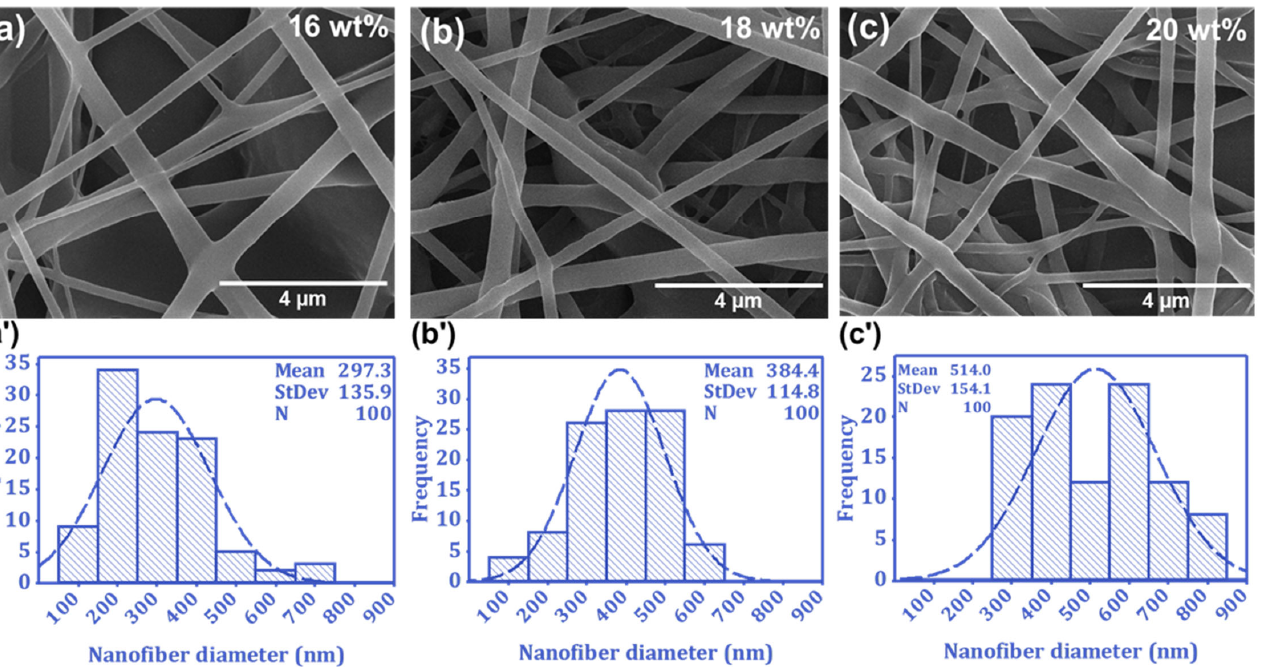
Figure 3. ( a – c ) SEM images and ( a ′ – c ′ ) diameter distribution of PU − NFs at 16, 18, and 20 wt% PU concentration. Figure 4c shows the FTIR spectra of pristine PU-NFs, the 6% SiO 2 @PU − NFs mem- brane, and the spectrum SiO 2 -NPs. In pure SiO 2 -NPs, the two crucial peaks, at 1087 and 780 cm − 1 , are characteristic Si-O-Si and Si-C stretching bands, respectively [44]. The ab- sorption band at 3310 cm − 1 corresponds to the NH stretching for PU − NFs [45].